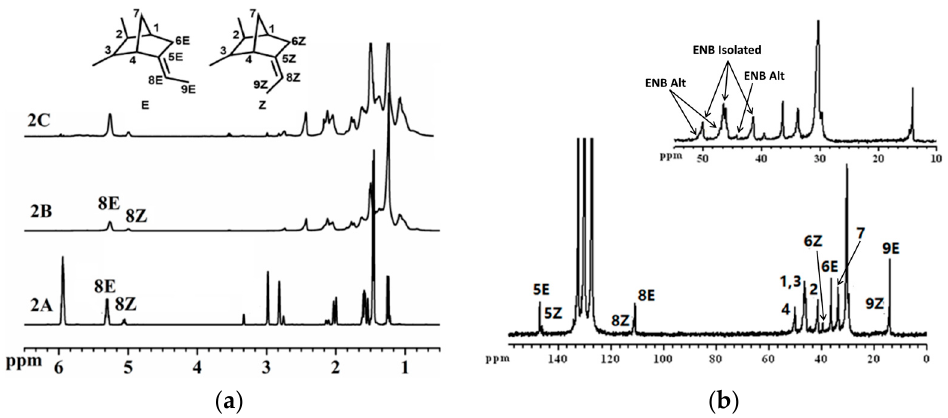
Figure 4. ( a ) 1 H NMR spectra of ENB monomer (2A), E/ENB copolymer with 17.8 mol % of ENB content (2B, Entry 1 in Table 2) and E/ENB copolymer with 30.4 mol % of ENB content (2C, Entry 9 in